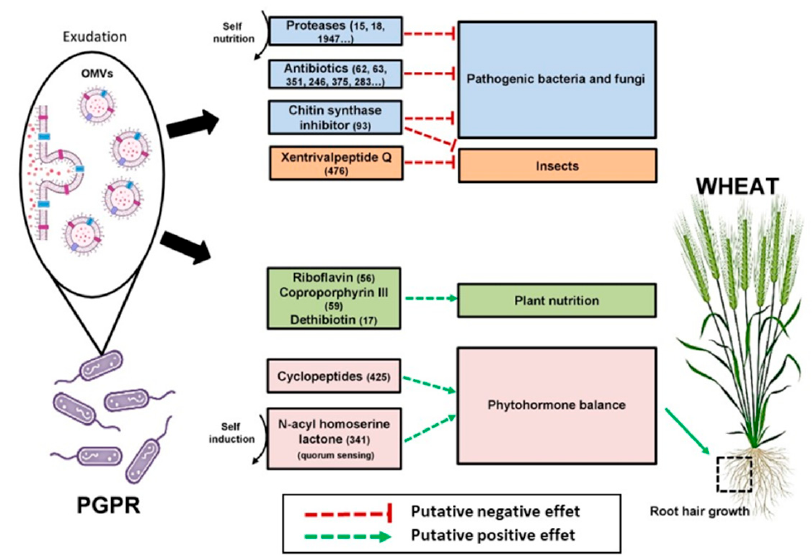
Figure 8. Exo-metabolites and exo-proteins constitutively exudated by BPMP-PU-28 ( Pseudomonas urmiensis ) and BPMP-EL-40 ( Enterobacter ludwigii ); diverse and complex pathways are likely to give rise to beneficial interactions with the plant.